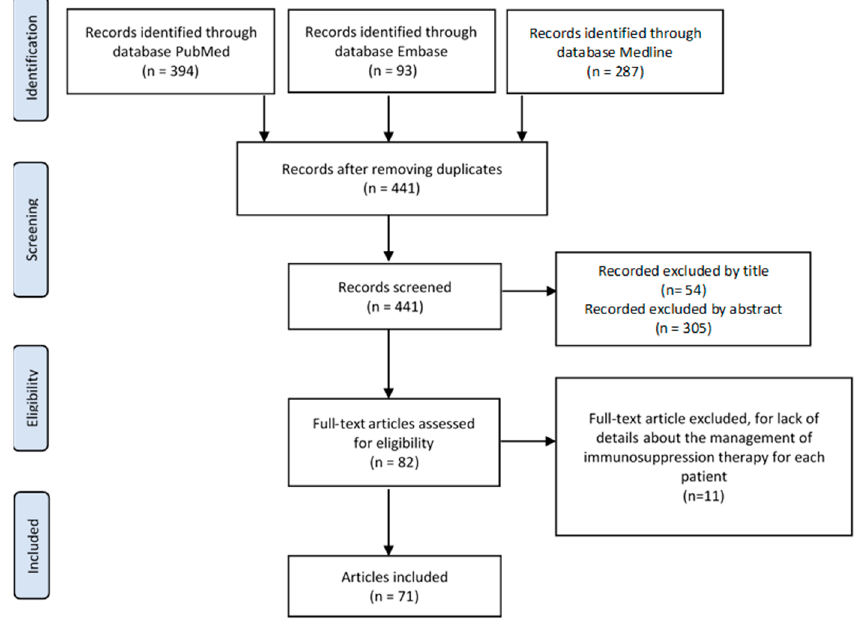
Figure 1. Flowchart of the literature search and study selection.